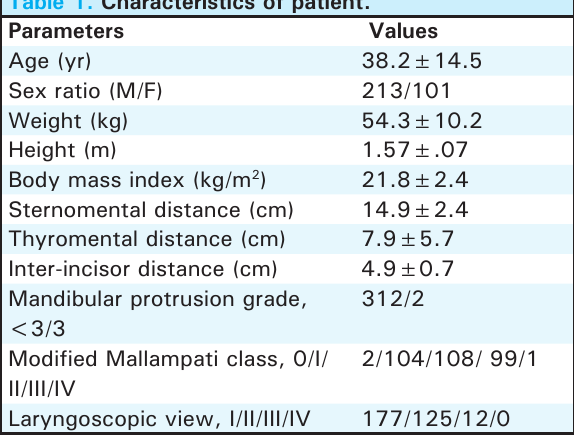
Table 1. Characteristics of